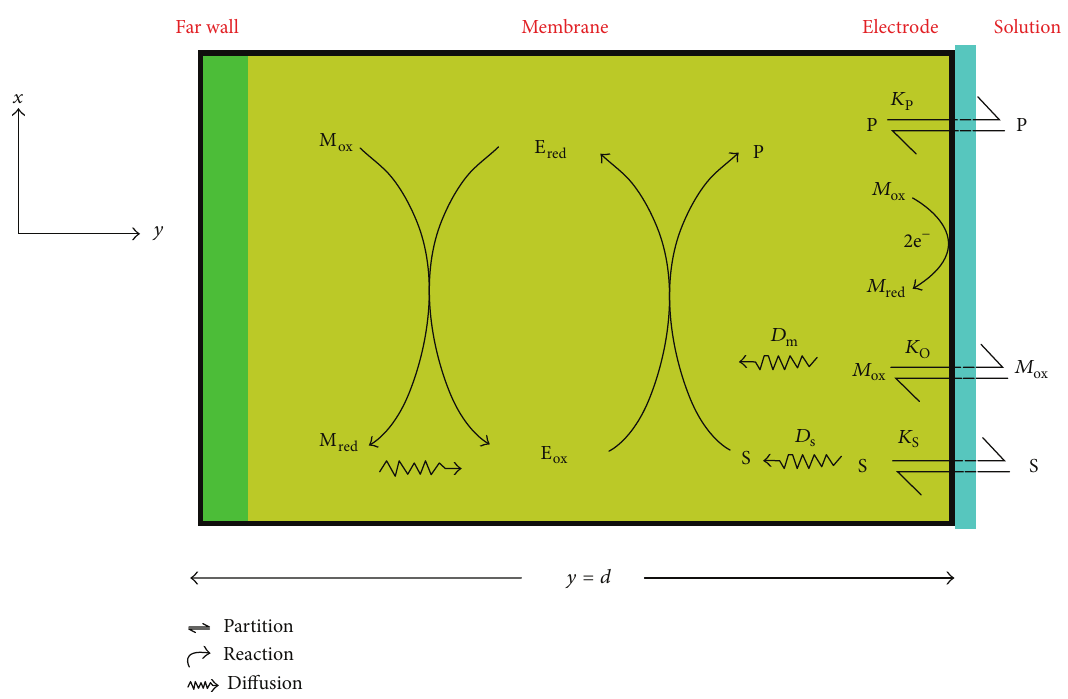
Figure 1: Schematic representation of a typical enzyme-membrane electrode geometry